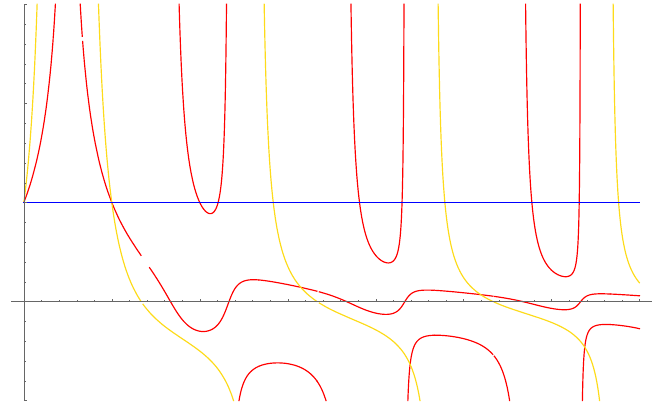
Figure 6 . The eigenvalues of the kernels of the 4-point functions in the model (3.1). The yellow curves represent the diagonal eigenvalue k 11 , while the red curves are from diagonalizing the matrix of k 22 , k 23 , k 32 and k 33